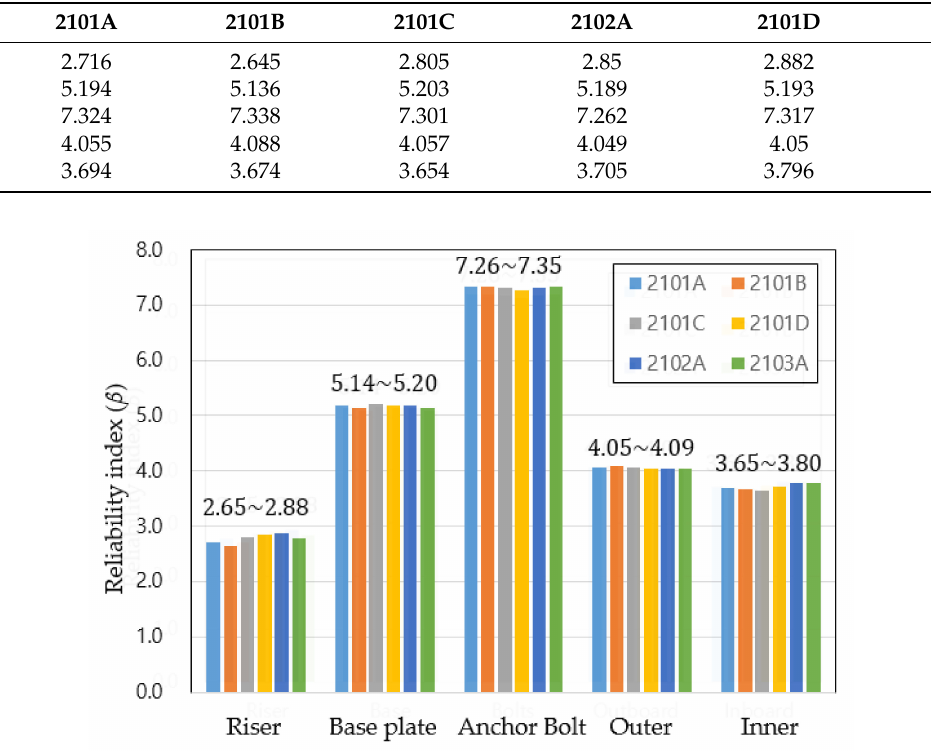
Figure 11. Summary of the reliability index of ULAs classified by components. Table 10. Probability failure results of structural